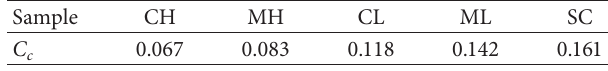
Table 4: Compression indexes of different soil